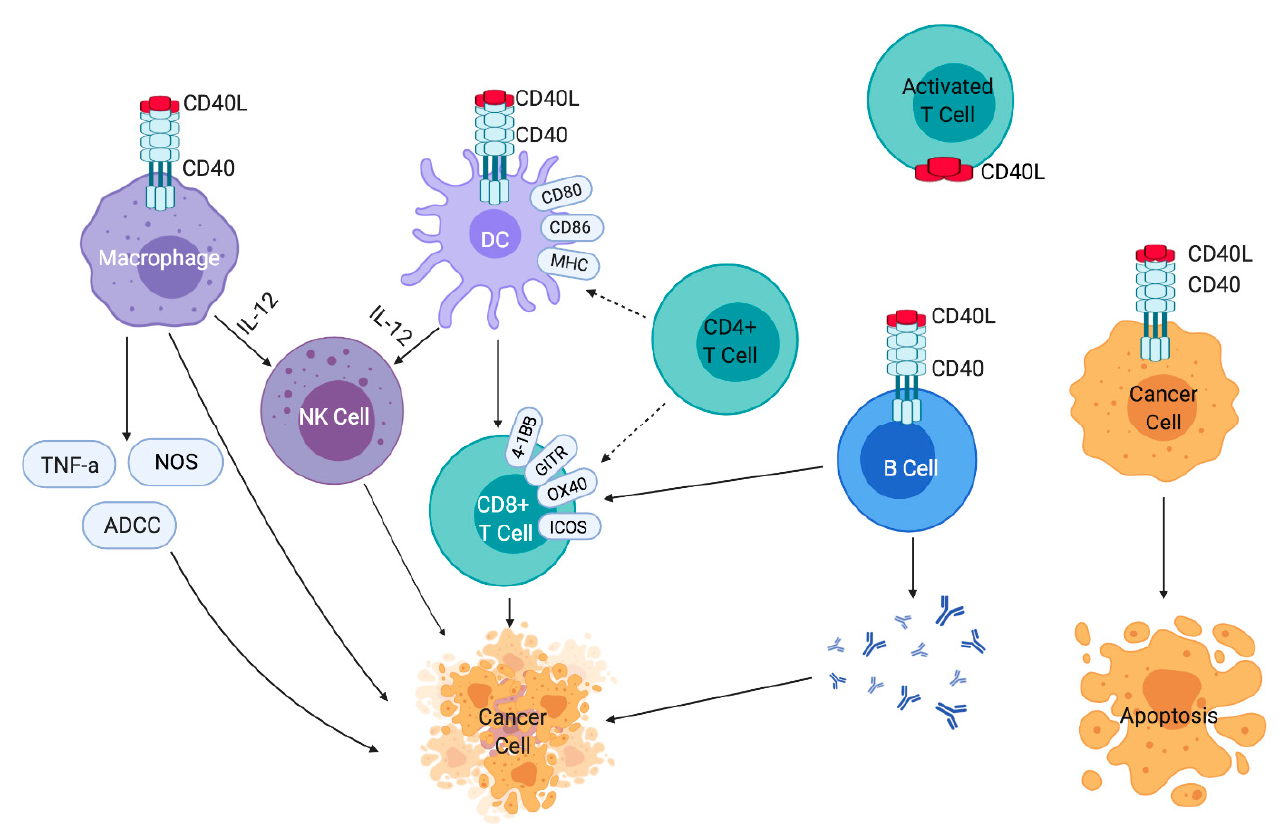
Figure 1. Effects of CD40-CD40L signaling on immune cells and cancer cells. CD40L is expressed on activated T cells. CD40-CD40L binding on macrophages results in the production of tumor necrosis factor-alpha (TNF- α ), nitric oxide synthase, and antibody-dependent cellular cytotoxicity (ADCC). CD40-CD40L binding on dendritic cells and macrophages results in the secretion of interleukin 12 (IL-12), which is important for T cell and NK cell-mediated antitumor effects. CD40-CD40L activation on B cells supports T cell immunity and antibody production. Cancer cells may also be directly affected and undergo apoptosis after CD40 activation.